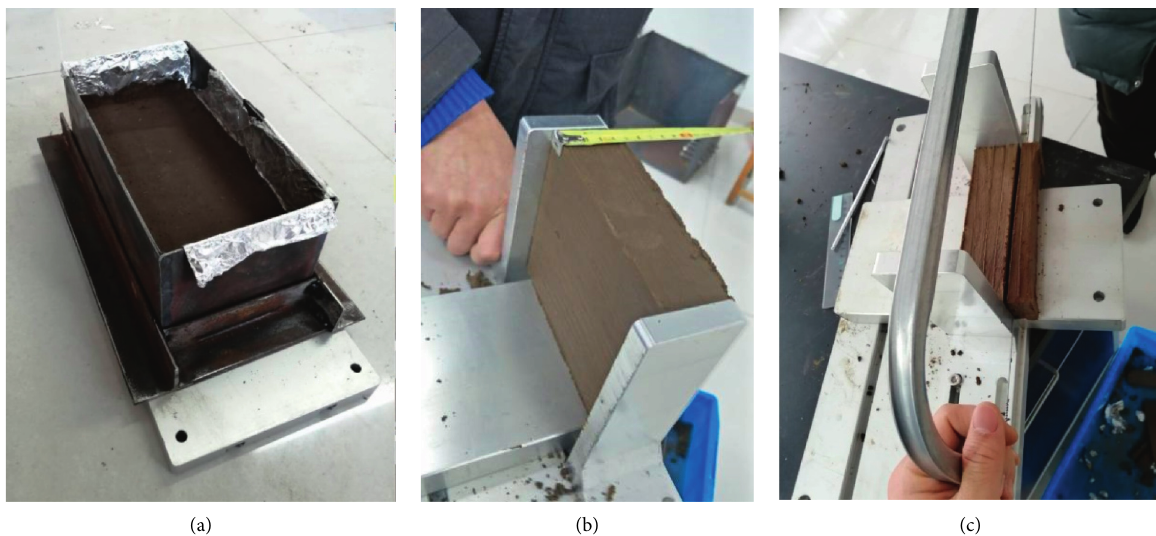
Figure 2: (a) The molds for compacting clay; (b) the adjustable fixture; (c) cutting soil blocks by fretsaw.